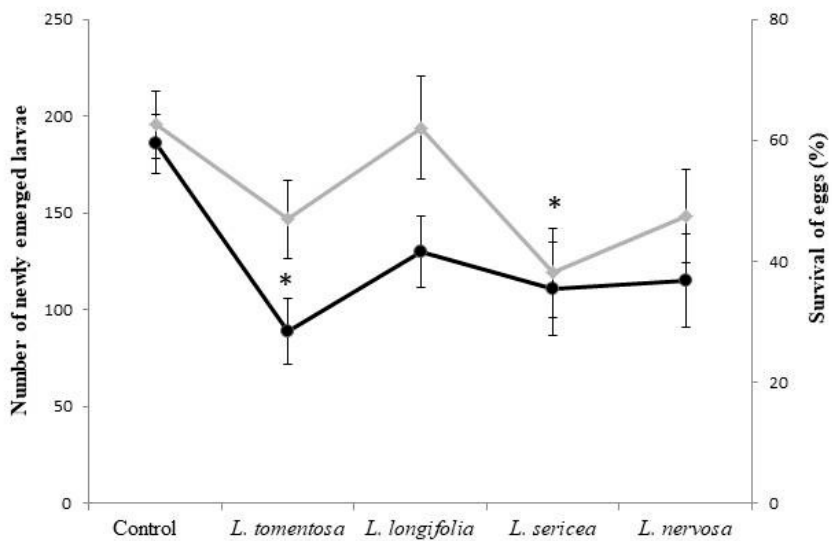
Figure 3. Number of newly emerged larvae (dark line) and survival of eggs (%) (light line) of Plutella xylostella treated with Ludwigia spp. aqueous extracts. Each data point represents mean ± standard error. ( ● ) Mean number of newly emerged larvae, and ( ♦ ) mean percentage of survival of eggs. Asterisks indicate significant differences ( * p < 0.05), as determined by the Kruskal–Wallis test.